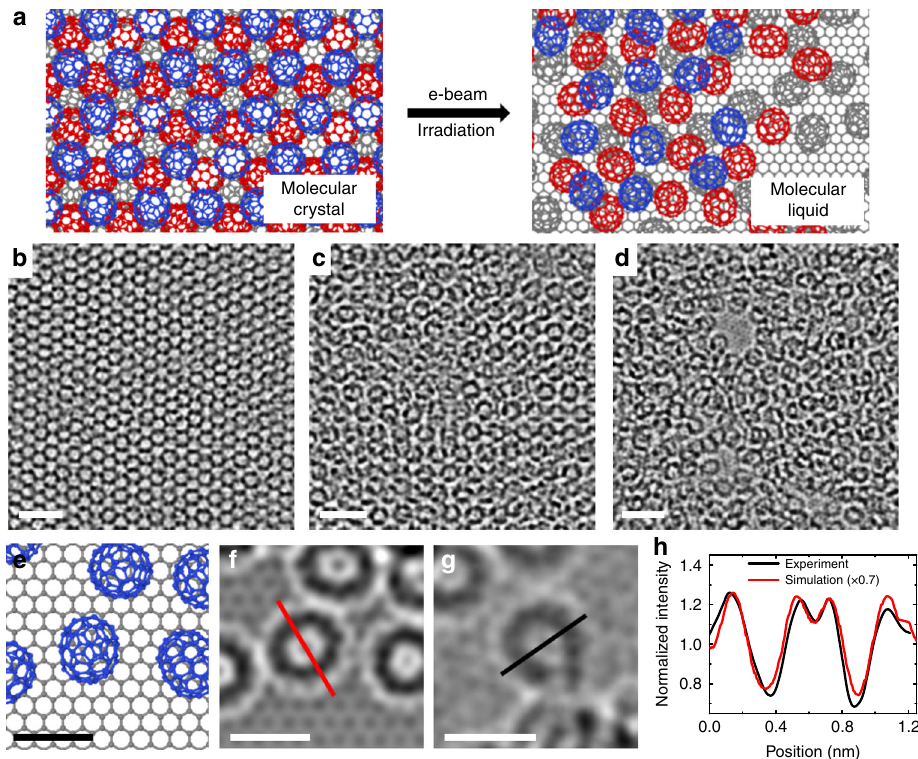
Fig. 1 Electron beam irradiation on C 70 molecular crystal. a Atomic models of C 70 assembly on graphene showing the order-to-disorder structural transition under e-beam. b – d TEM images of C 70 molecular arrangement under e-beam showing increased structural disorder. Scale bar, 2 nm. e Atomic model, f corresponding TEM simulation image, and g experimental TEM image of an isolated C 70 molecule on graphene. Scale bar, 1 nm. h Intensity pro fi le comparison between simulation and experimental images along red and black lines in f , g